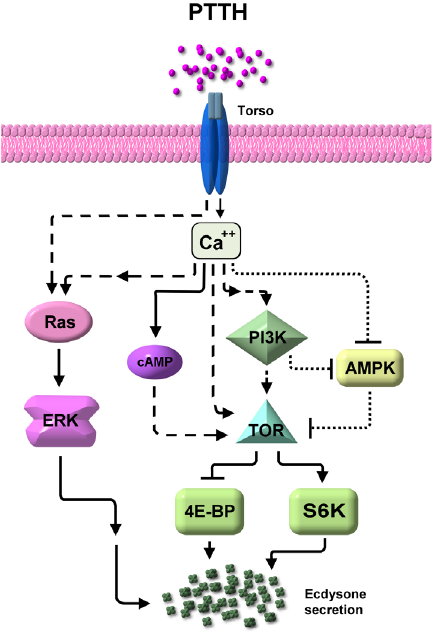
Figure 1. The signaling network involved in PTTH-stimulated ecdysteroidogenesis in prothoracic gland cells. Solid lines indicate demonstrated or highly likely relations; dashed lines indicate hypothetical interactions; dotted lines indicate the relationship demonstrated in the present study. PTTH, prothoracicotropic hormone; Ras, Ras GTP-binding protein; ERK, extracellular signal-regulated kinase; cAMP, cyclic adenosine monophosphate; PI3K, phosphatidylinositol 3- kinase; TOR, target of rapamycin; 4E-BP, eIF4E-binding protein; S6K, p70 ribosomal protein S6 kinase; AMPK, adenosine 5 9 -monophosphate- activated protein kinase (ref. 2, 3 and this work).